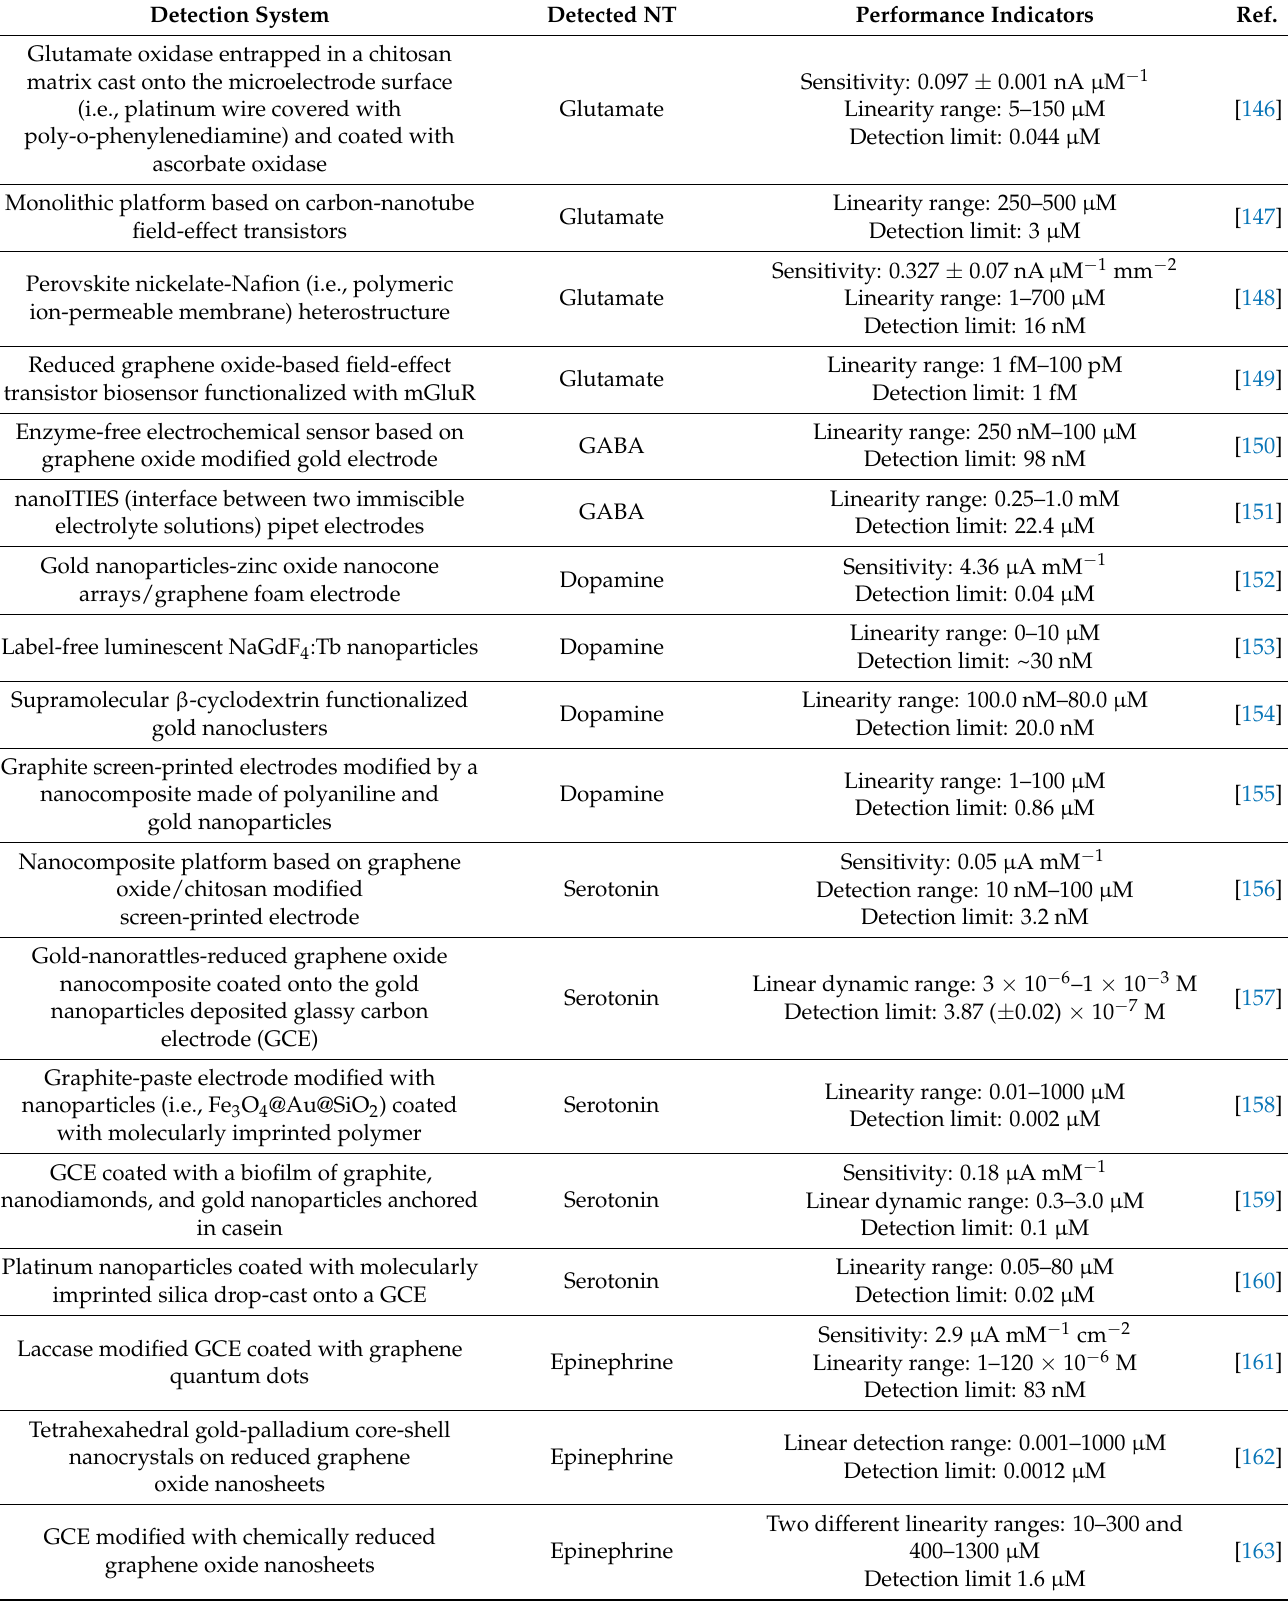
Table 1. Examples of nanomaterial-based NT detection